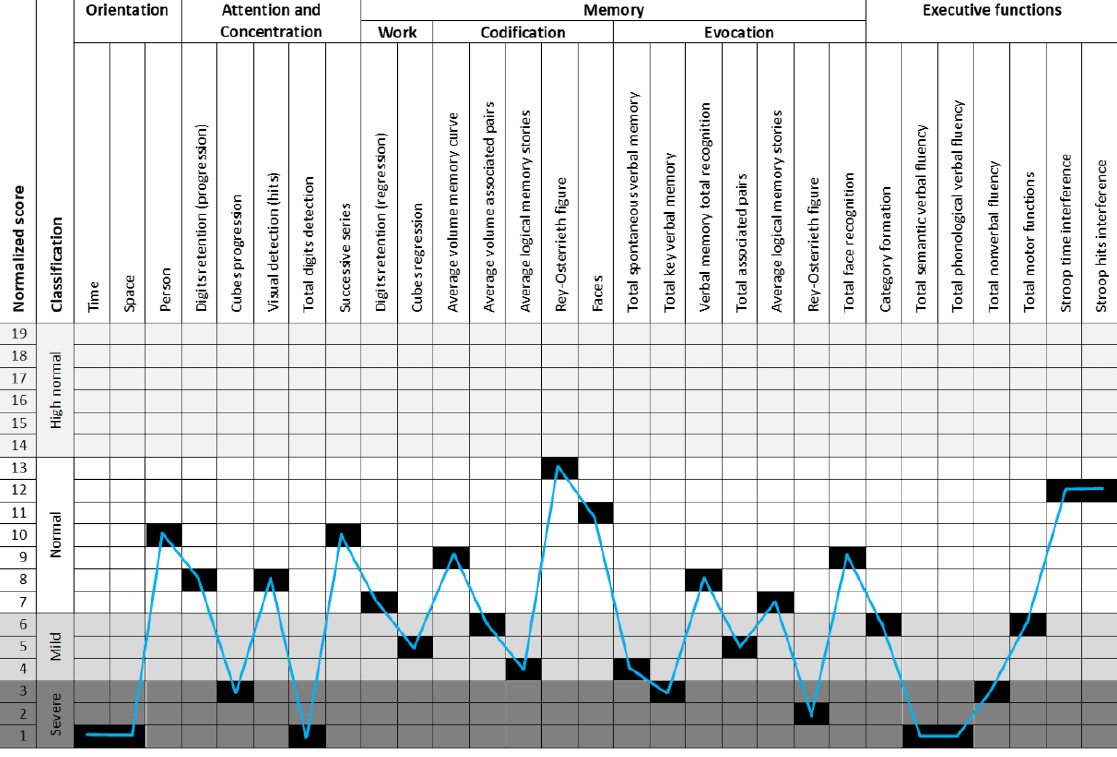
(attention, memory, and executive functions). Most of the results revealed mild and severe alterations.